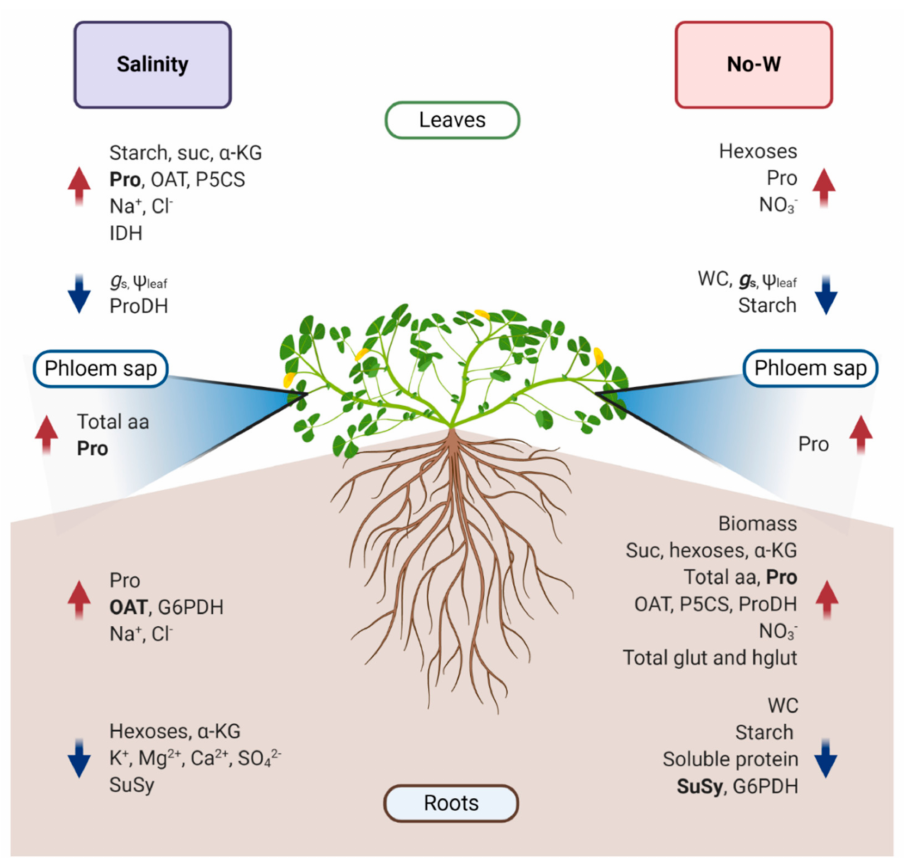
Figure 4. Summary of the most relevant M. truncatula responses to salinity and drought stress. This image depicts the increases and decreases in physiological parameters as well as enzymatic activities and metabolite and nutrient concentrations in leaves, roots and phloem sap under NaCl and no-irrigation (No-W) compared to control conditions. Bolded text indicates a higher increase or decrease in the studied parameter compared to the other stress. aa, amino acids; glut, glutathione; G6PDH, glucose-6-phosphate dehydrogenase; g s , stomatal conductance; hglut, homoglutathione; IDH, isocitrate dehydrogenase; α -KG, α -ketoglutarate; OAT, ornithine aminotransferase; P5CS, ∆ 1 -1-pyrroline-5-carboxylate synthase; ProDH, proline dehydrogenase; Suc, sucrose; SuSy, sucrose synthase; WC, water content; Ψ leaf , leaf water potential. (Created with BioRender.com, accessed on